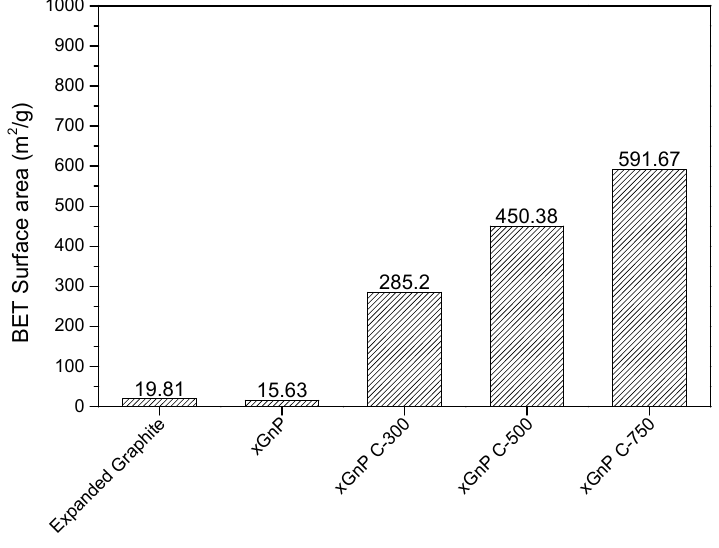
Figure 4. BET surface area of each porous carbon material.